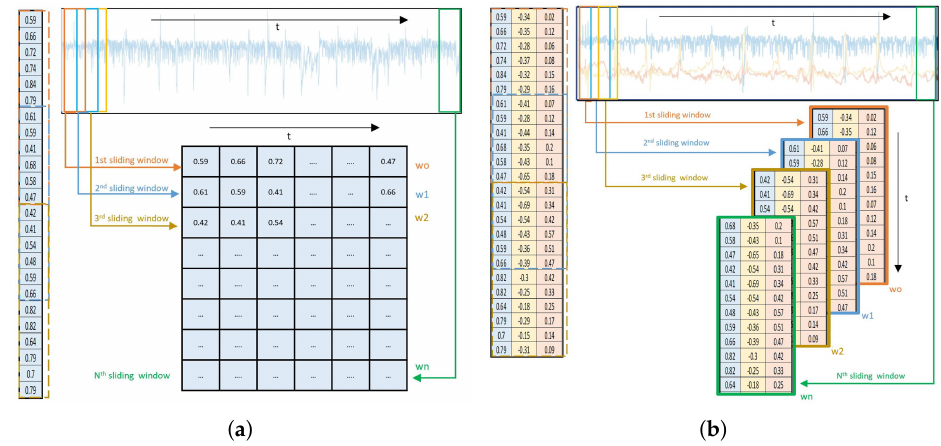
Figure 6. The detailed process of the sliding window approach with a window size of 12 and a stride of 6 are depicted in both cases. ( a ) univariate time-series data; ( b ) multivariate time-series